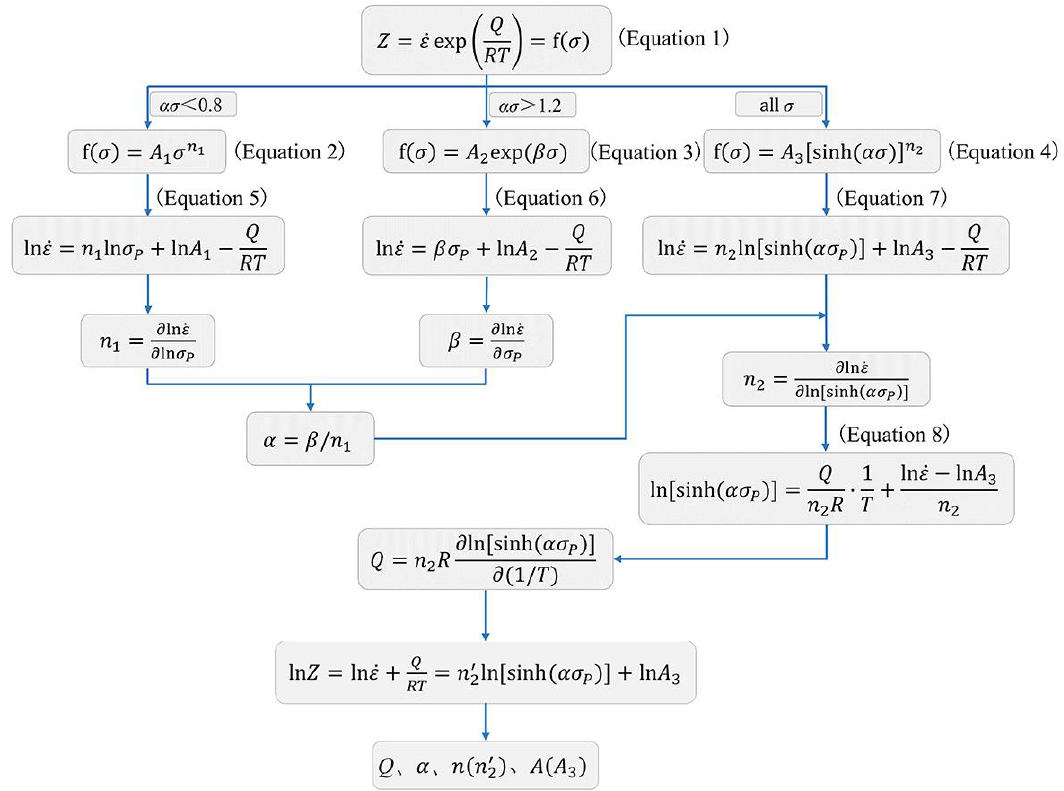
Figure 5. Seventh-order fitting curves of each of the material-dependent constants: ( a ) Q-ε ; ( b ) α-ε ; ( c ) n-ε ; ( d ) ln A-ε.